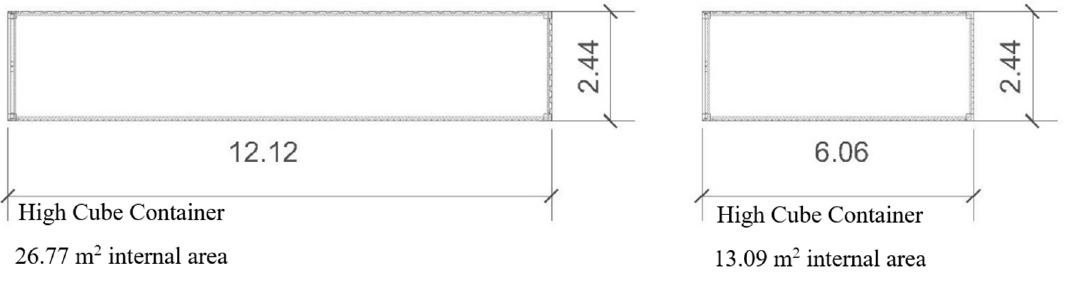
Figure 6. Types of containers used in the case study.